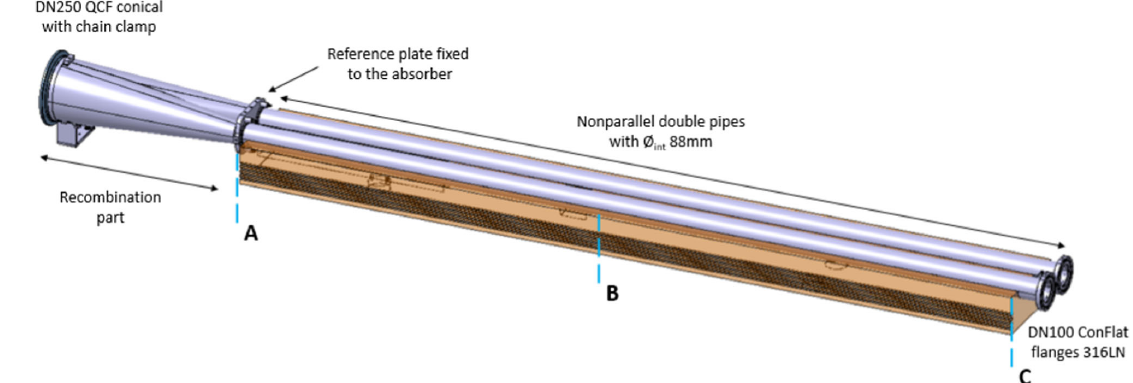
FIG. 6. Recombination chamber design inserted in an absorber clamp. A, B, and C indicate the tolerance breakdown described in Table